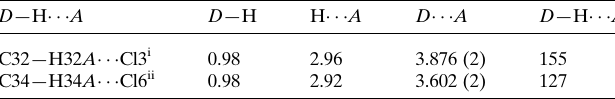
Table 1 Hydrogen-bond geometry (A˚ , (cid:5) ).